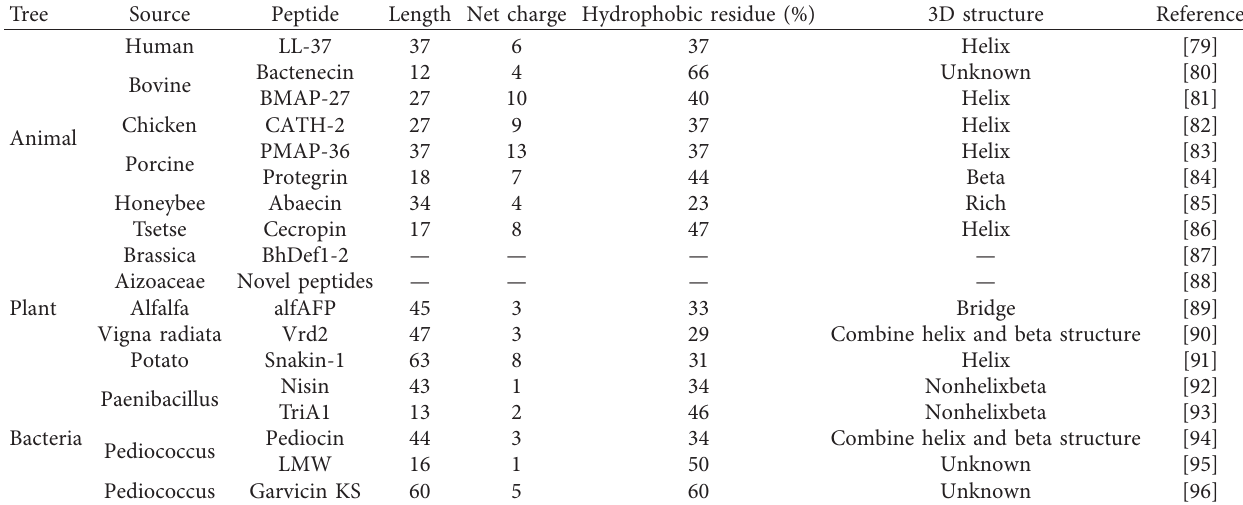
Table 1: Physicochemical properties of AMPs mentioned in this